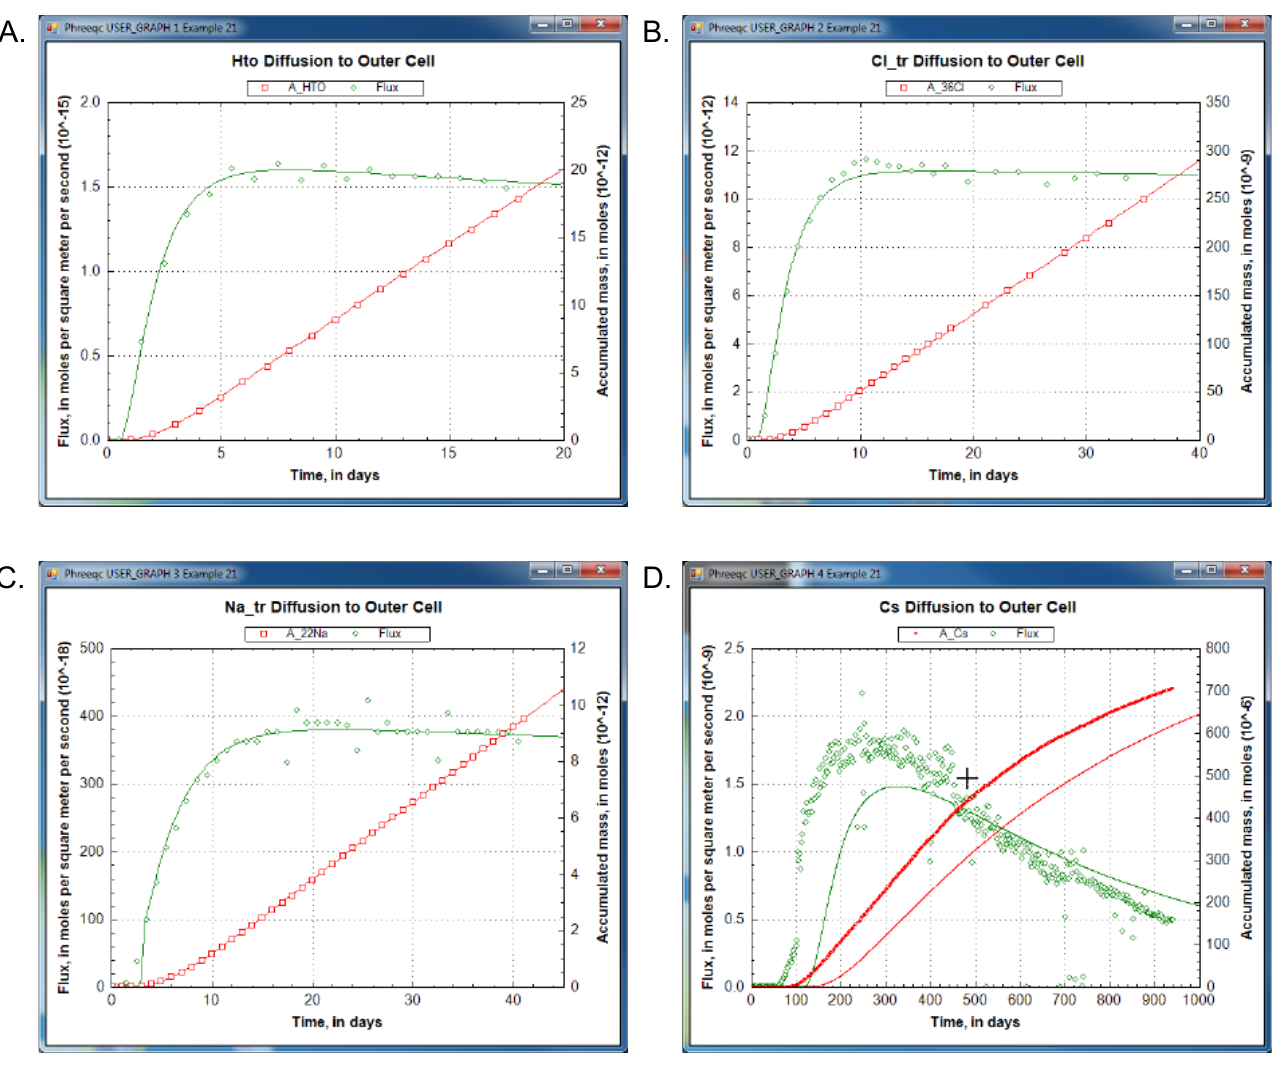
Figure 24. Mass outflow (red) and corresponding flux (green) by diffusion through the radial cell for (A) HTO, (B) 36 Cl - , (C) 22 Na + , and (D) Cs + . Lines are modeled; symbols indicate measured